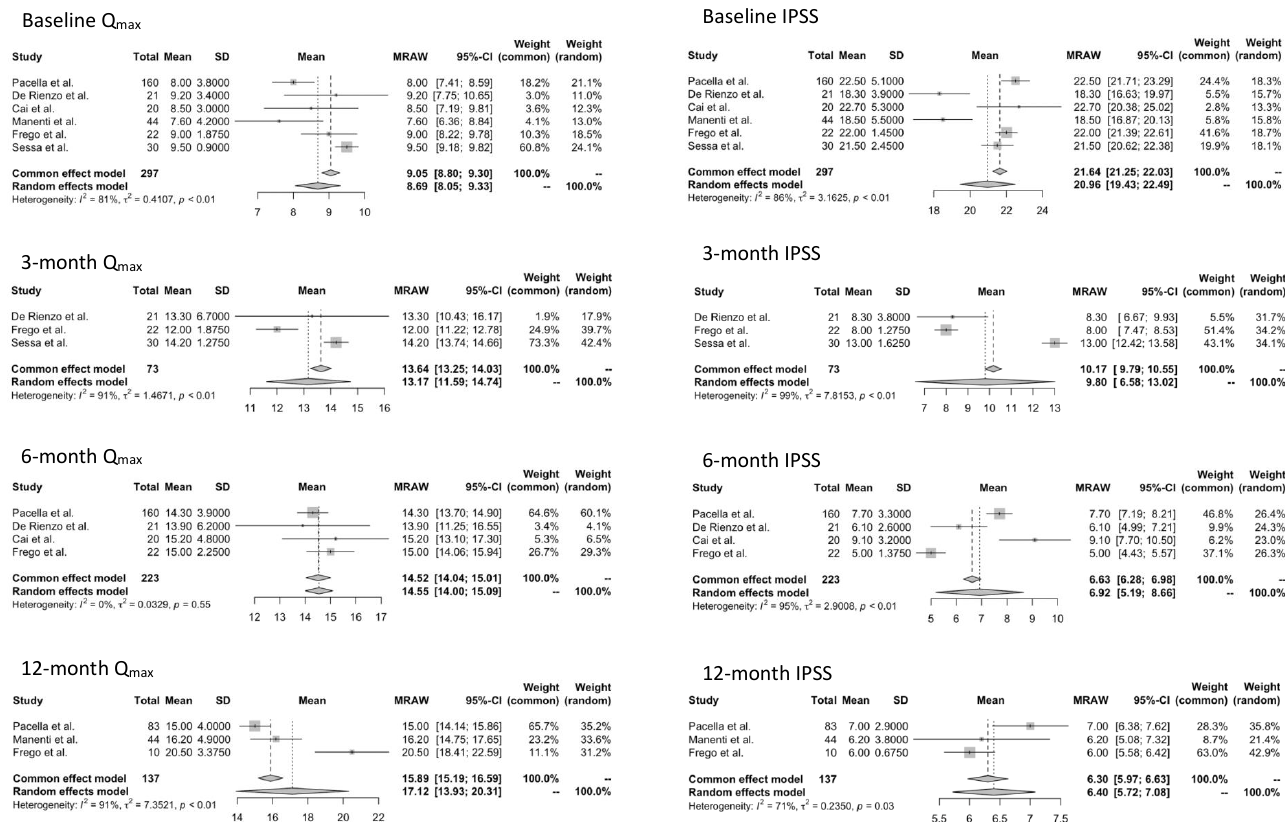
Figure 2. Forest plots illustrating the pooled mean and 95% confidence interval (CI) for maximum flow rate (Q max ) and International Prostatic Symptoms Score (IPSS) at baseline and during follow- up [7–12].